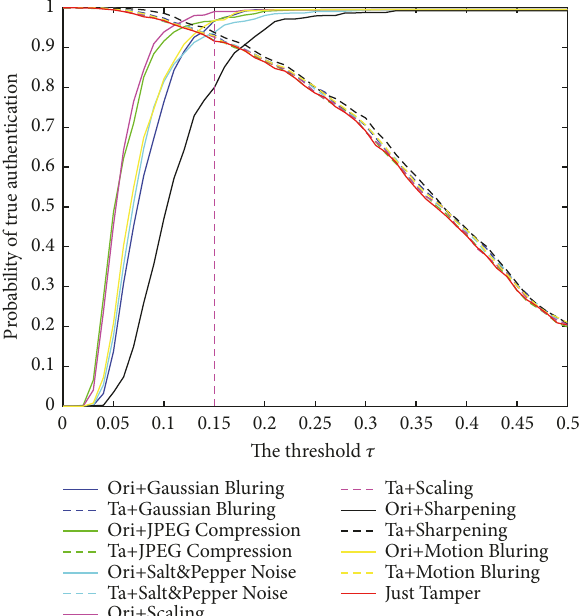
Figure 2: Image authentication performances with varying thresh-